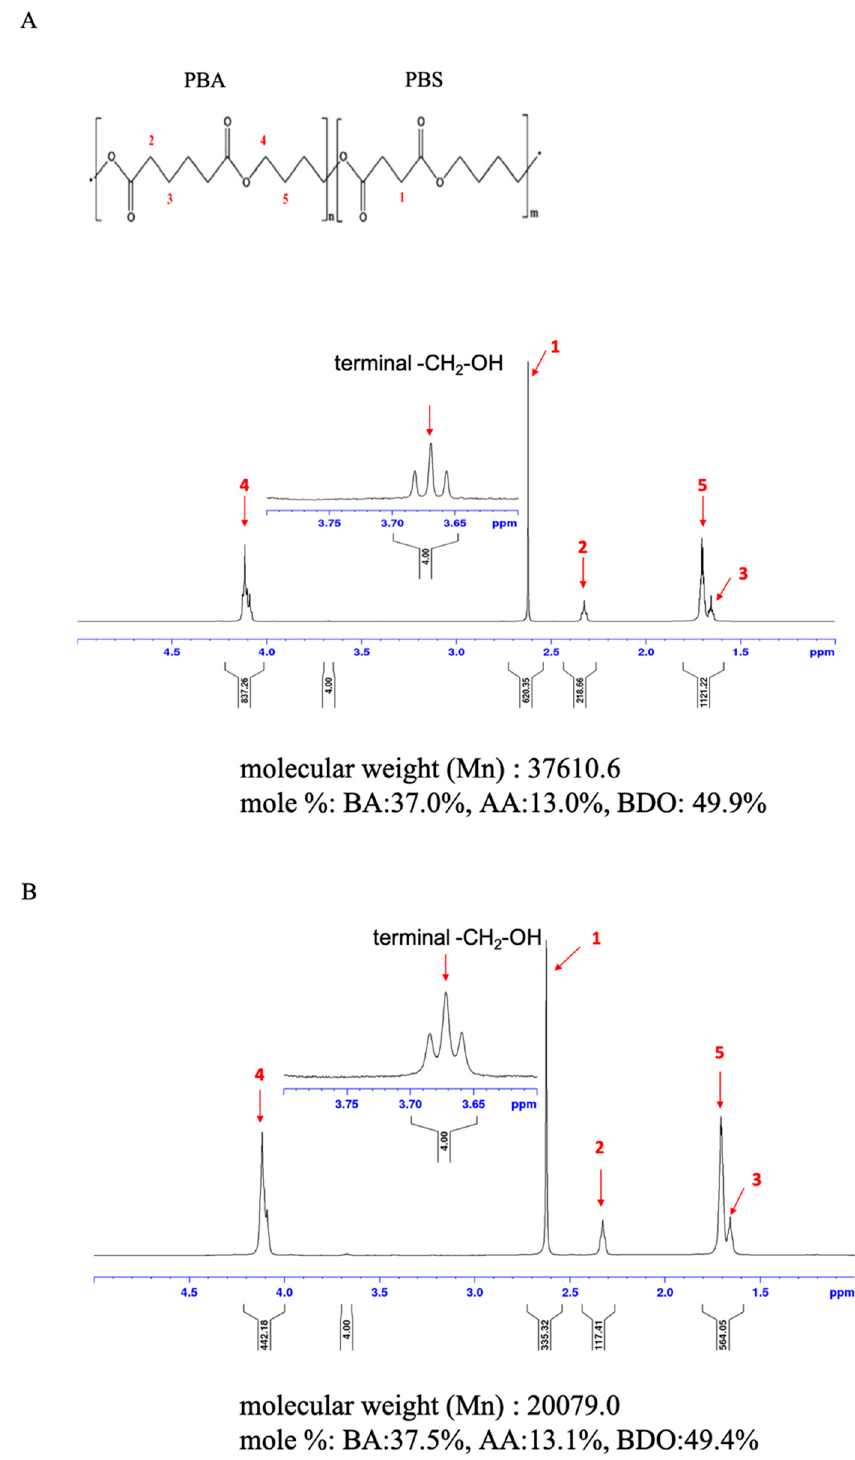
Figure 5. NMR spectra of PBSA films after degradation by A. terreus HC. ( A ) PBSA film without degradation. ( B ) PBSA film degraded by A. terreus HC for 30 days. Compared with the original PBSA film, the PBSA film, after 30 days of biodegradation, showed a lower number average molecular weight (Mn) but a similar monomer composition ratio. Peaks 1–5 correspond to the main signals of protons shown in ( A ) and ( B ). Peak 1 represents succinic acid (SA), peaks 2 and 3 represent adipic acid (AA), and peaks 4 and 5 represent 1,4-butanediol (BDO).